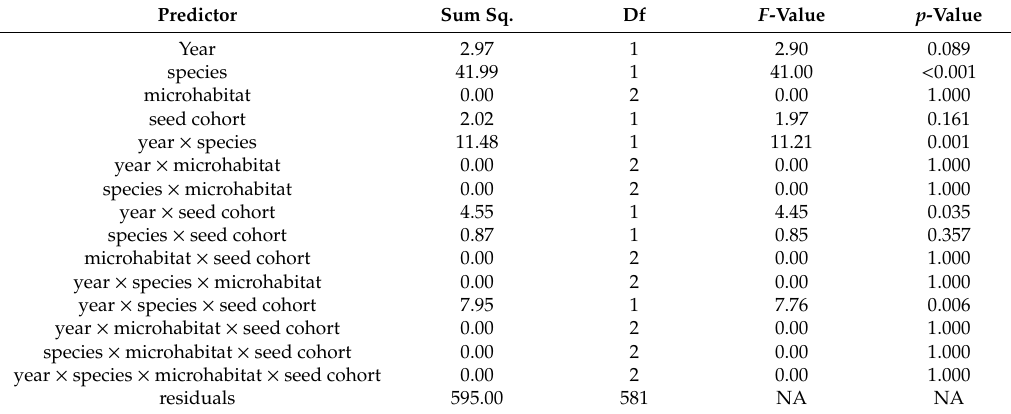
Table 3. Results from quasibinomial generalized linear models evaluating e ff ects of year, species, microhabitat, seed cohort, and all interactions on results of stain-based assays (i.e., % of seeds from the retained seed pool that stained red). Bold text indicates a significant di ff erence at the p ≤ 0.05 level 1 ; italic text indicates a marginally significant di ff erence at the p ≤ 0.10 level. Predictor Sum Sq. Df F -Value p -Value Year 2.97 2.90